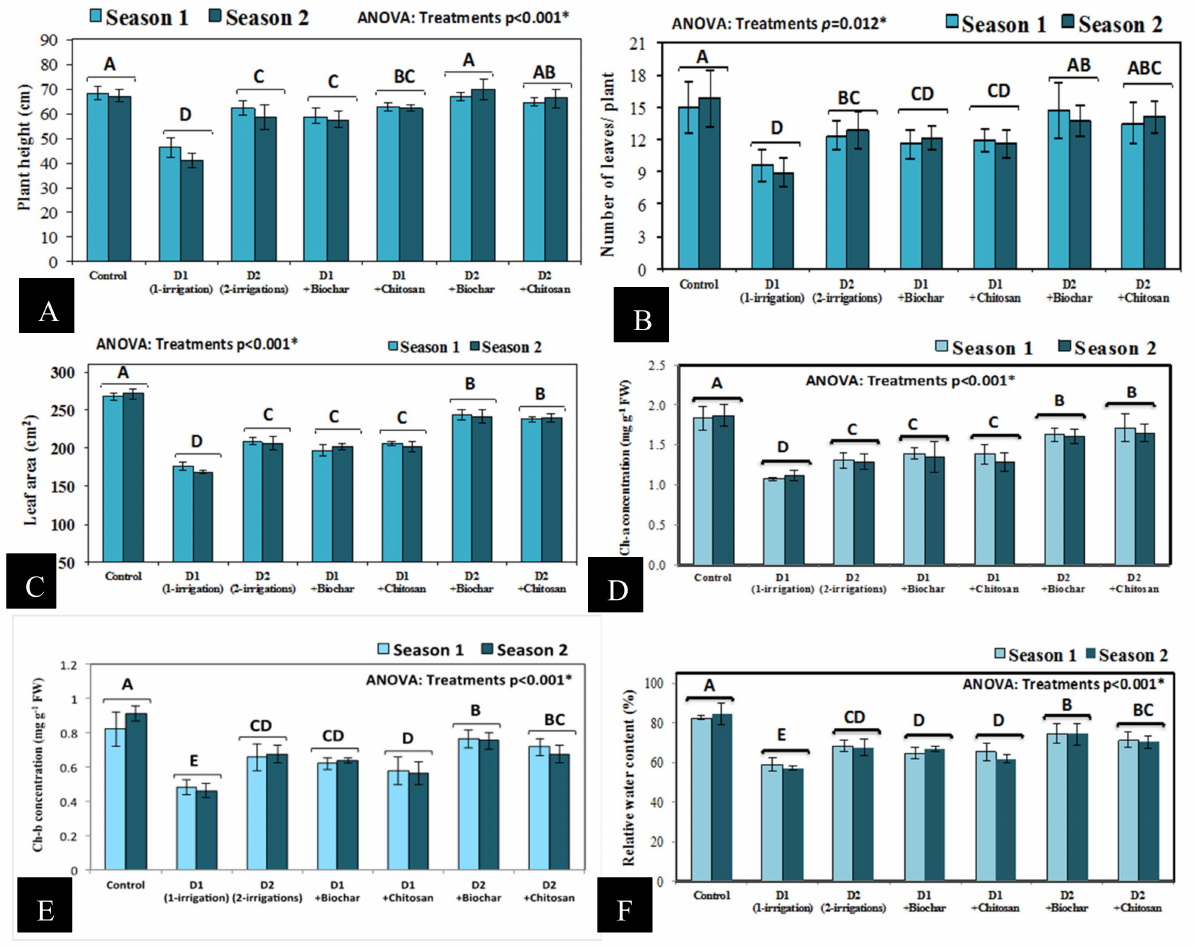
Figure 1. E ff ect of biochar and chitosan on plant height ( A ), number of leaves ( B ), leaf area ( C ), chlorophyll concentrations ( D,E ), and relative water content ( F ) of barley during two seasons (2017 / 2018–2018 / 2019). Bars followed by di ff erent letters are significantly di ff erent at p < 0.001. (D1) One irrigation (D2) Two